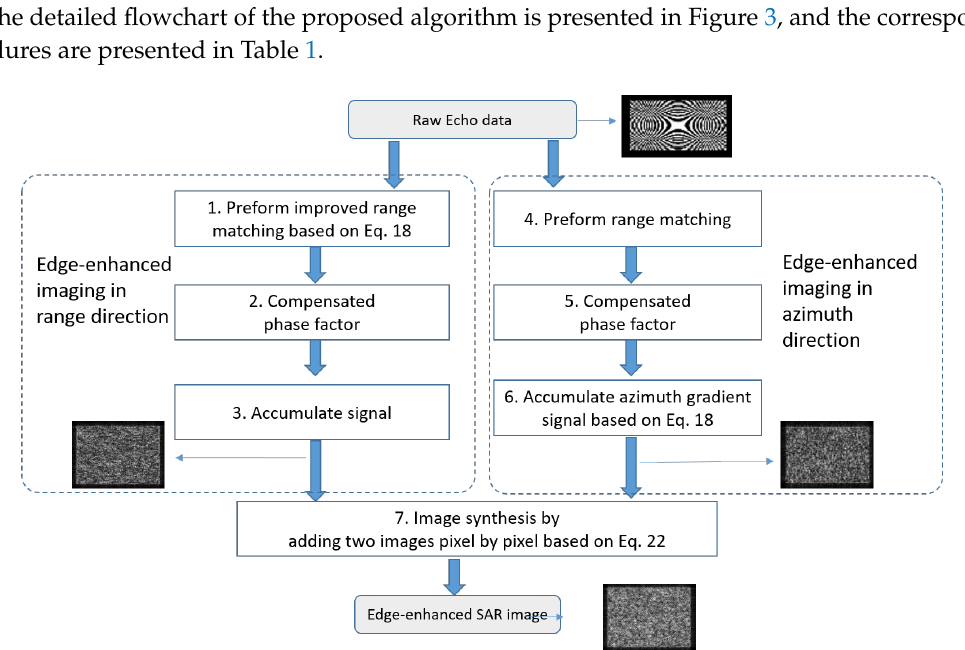
Figure 3. The flowchart of the proposed